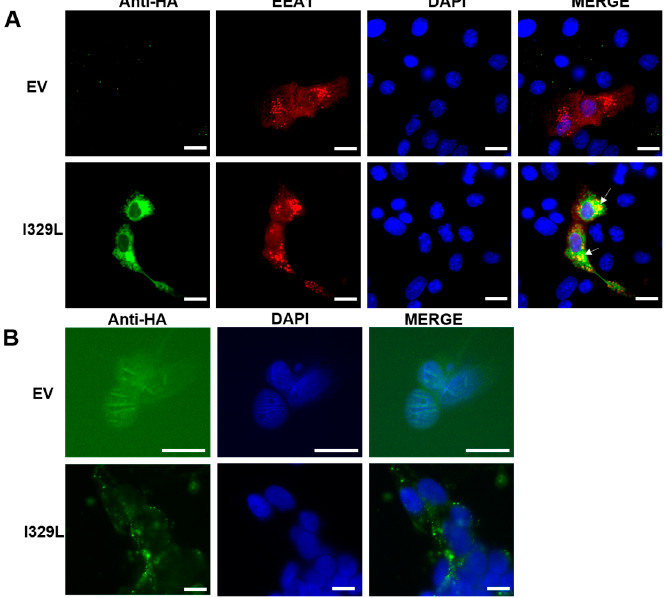
Figure 1. Localization of I329L to the early endosome and surface membrane. Indirect immunofluo- rescence was performed on: ( A ) Vero cells transfected with EEA1 Ct-tomato plasmid (to visualize early endosomes, shown in red) and pcDNA3-I329L-HA or empty control plasmid (EV), using an anti-HA antibody and anti-mouse cy5 conjugated secondary antibody to detect I329L expression (in green) and DAPI staining to define nuclei (in blue); and ( B ) In an alternative protocol, the cells were transfected with pcDNA3-I329L-HA or empty control plasmid (EV), and directly stained without permeabilization with an anti-HA antibody and anti-mouse Cy5 conjugated secondary antibody to detect I329L expression (in green) and counterstained with DAPI to define nuclei (in blue); Images were acquired with a 63× objective. Scale bars: 20 μ m.